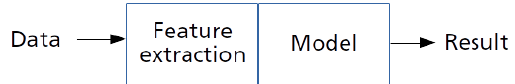
Figure 1. General processing pipeline for machine learning ap-